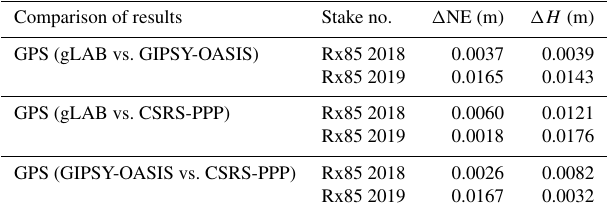
Table 1. Assessment of the GPS positions for two stake observa- tions in 2018 and 2019. Top lines: assessment of the processing results, gLAB vs. GIPSY-OASIS. The processing results from the open-source Canadian service CSRS-PPP software v. 1.05 is shown for comparison. (cid:49) NE is the difference in horizontal positions, and (cid:49)H is the difference in vertical positions. Comparison of results Stake no. (cid:49) NE (m) (cid:49)H (m) GPS (gLAB vs.